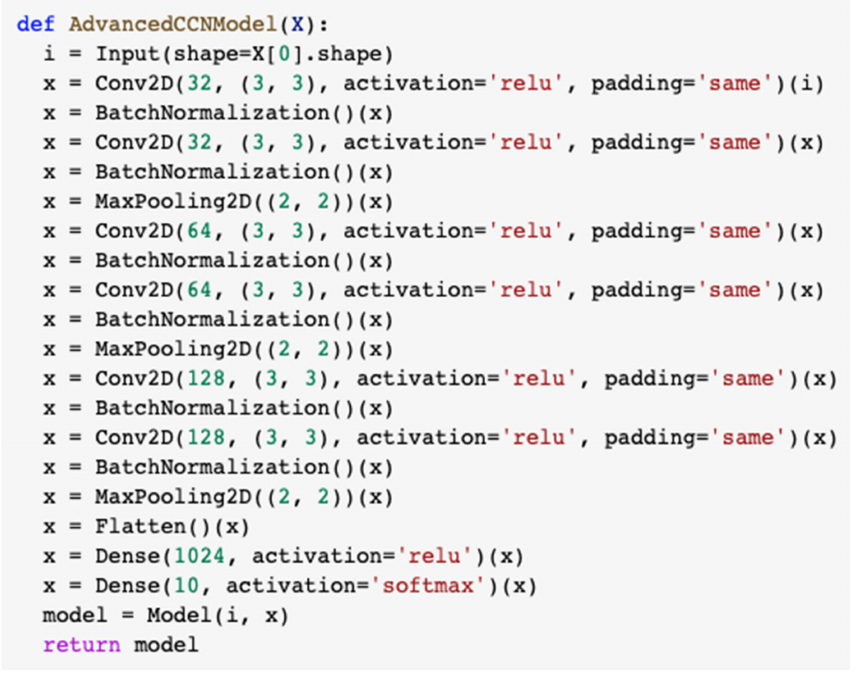
Figure A5. Advanced CNN Model Code.